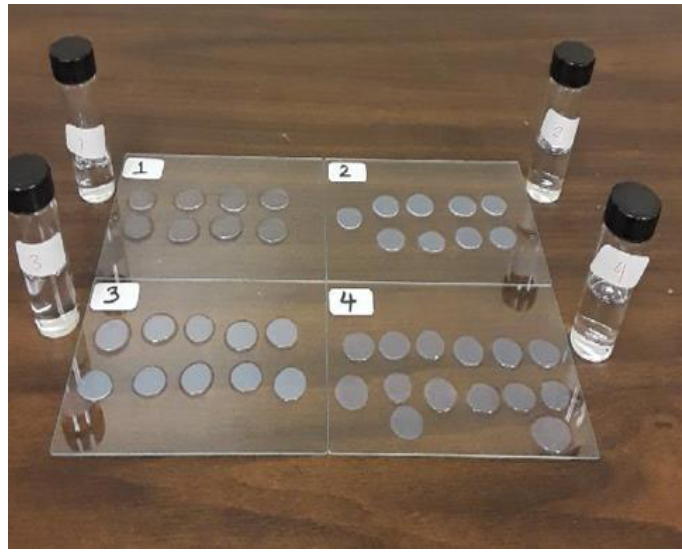
Figure 2. Nanodiamond-incorporated molecularly imprinted polymer hydrogel samples containing the four different concentrations of creatinine (0.82 µM, 2.40 µM, 4.10 µM, 6.20 µM).